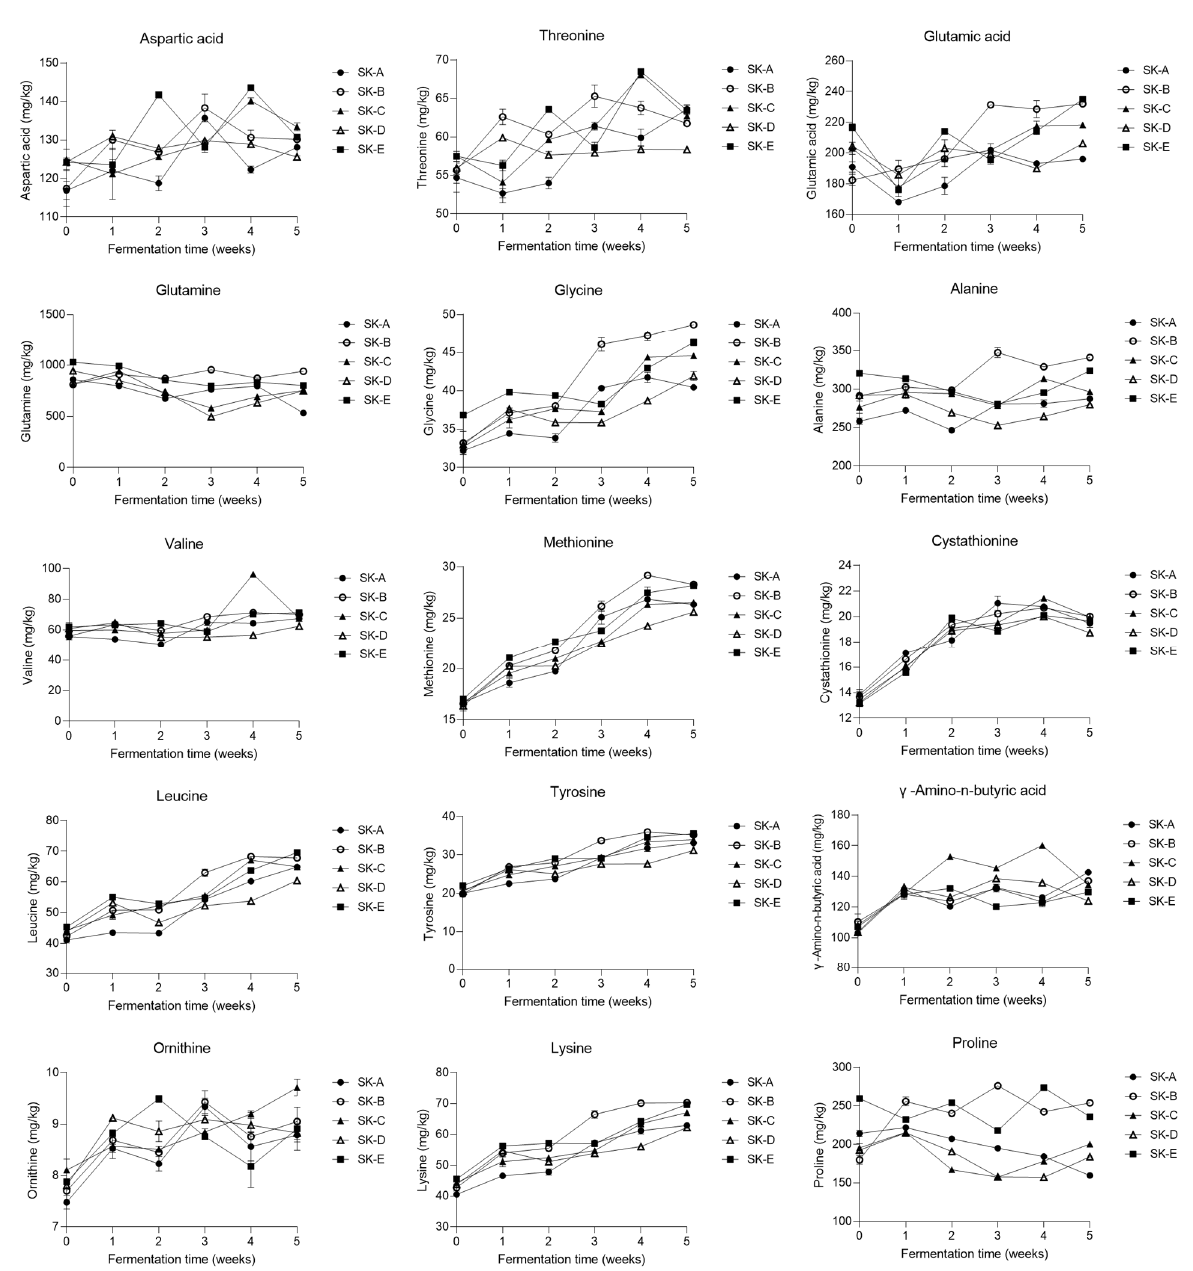
Figure 5. Changes in the free amino acid contents of kimchi samples with different salinities during fermentation.